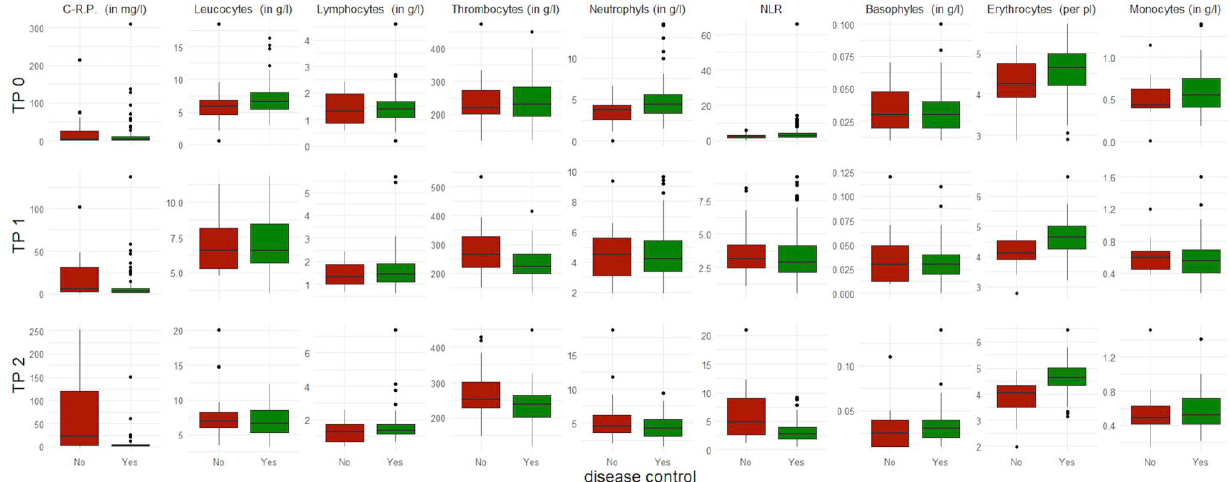
Figure 1. Boxplots of all included blood parameters per time point (TP) (at baseline TP 0 and at three and six months after starting immune checkpoint inhibition, respectively designated as TP 1 and TP 2) in patients with disease control at six months (displayed in green) versus patients with progressive disease at the same time (displayed in red). Table 2. Descriptive statistics of blood parameters in patients with disease control after six months